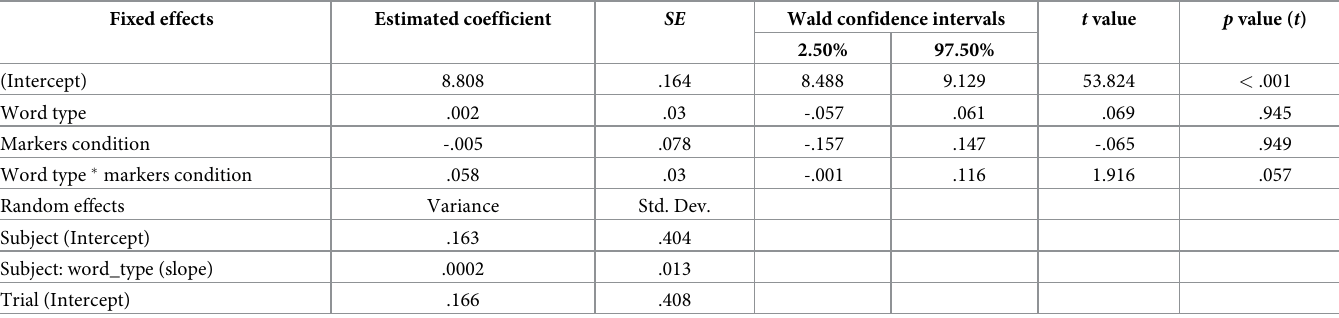
Table 6. Summary of the final linear mixed-effects model of (log transformed) looking times on the segmentation trials for participants in experiment 2.